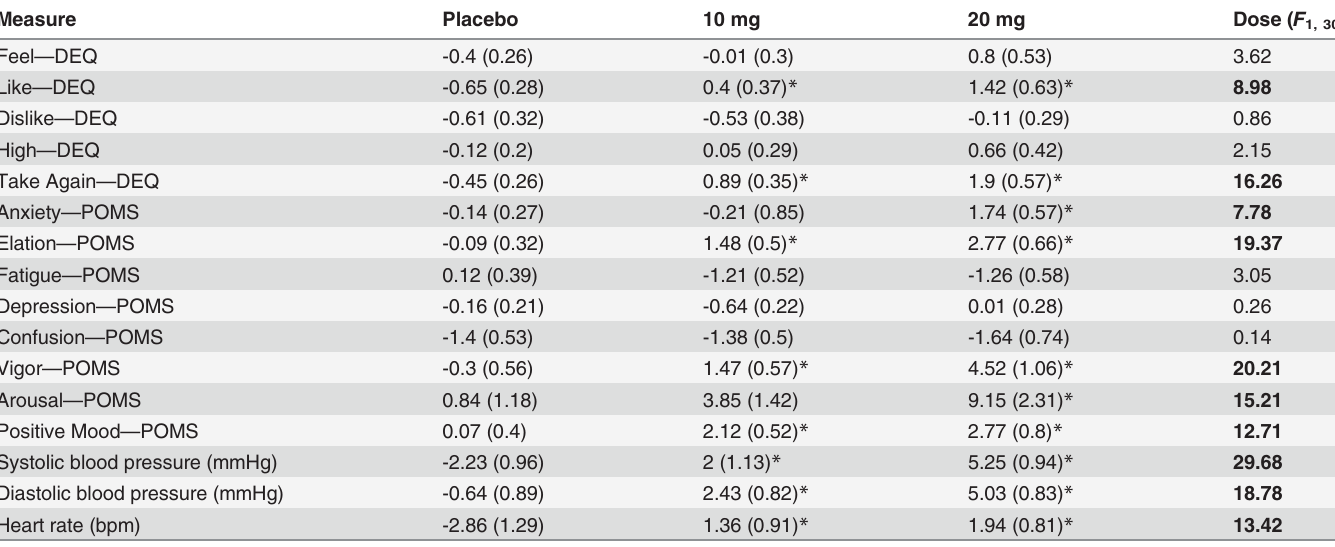
Table 5. Effects of METH on subjective and physiological measures in the consolidation group ( n =